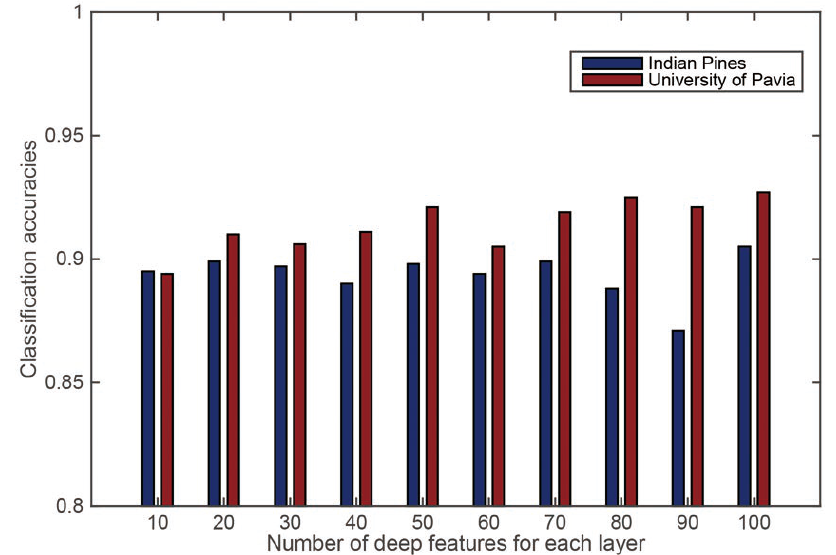
Figure 6. Classification results by setting different deep feature numbers for the CNN